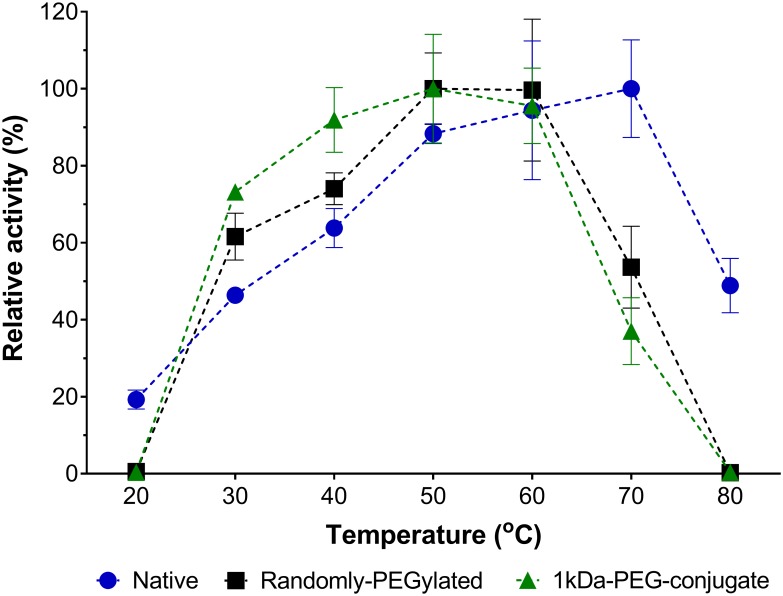
Reusability of the 1kDa-PEG-conjugate.Relative catalytic activity at temperatures ranging from 20°C to 80°C. The 1kDa-PEG-conjugate (in green), native L-asparaginase (in blue), and a commercial randomly-PEGylated L-asparaginase formulation (Millipore Sigma, USA) (in black). Relative catalytic activity was calculated by the absorption at 425 nm divided by the maximum signal for each sample and expressed as percentile (%). Reported values are average with error bars representing the 95% confidence interval. For the 1kDa-PEG-conjugate the same sample (semi-solid gel) was used throughout all the experiment.